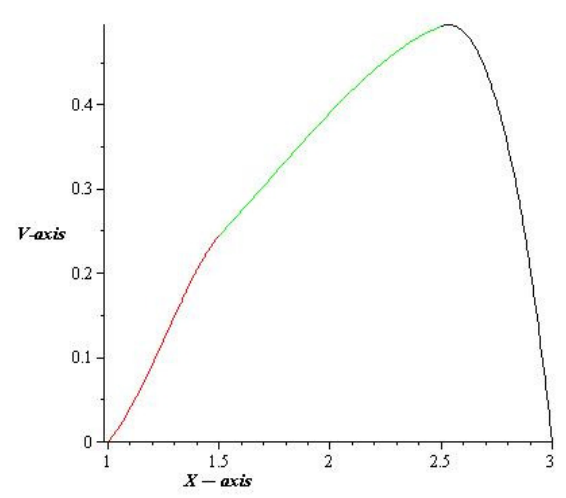
Figure 5. Analytical solution of the problem (c.f. Equation (1)) by HPM for α = 1.75.